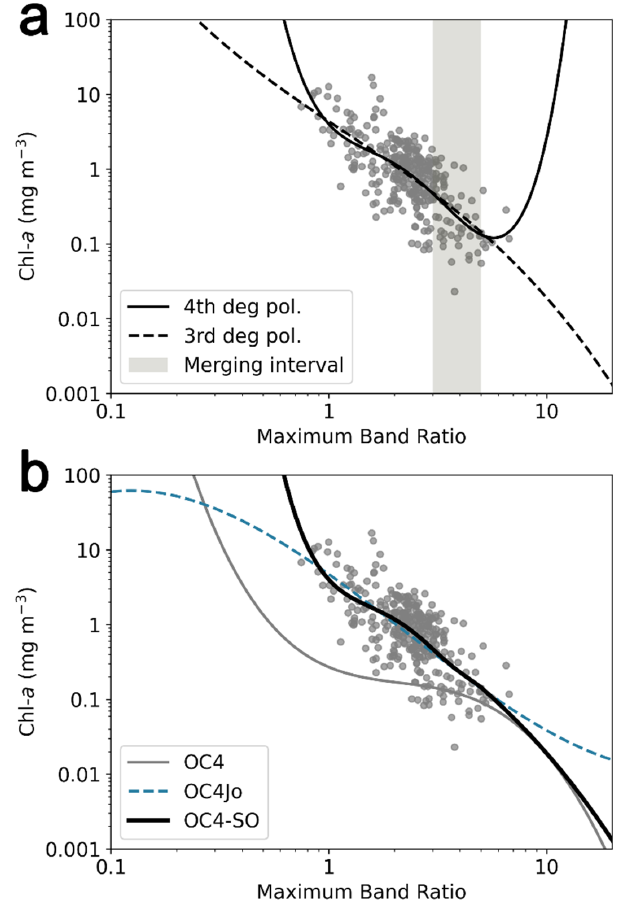
Figure 8. Relation between the in-situ Chl- a concentration and satellite maximum band ratio found for the match-ups in this study (N = 316). ( a ) Fitted 3rd- and 4th-degree polynomial functions that were used to derive the OC4-SO algorithm, along with the merging interval between MBR = 3 and MBR = 5, which was used to merge the two polynomial functions. ( b ) Comparison of the new algorithm (OC4-SO) and the regional OC4Jo. The global algorithm’s OC4 function [58] is also shown for comparison. Table 4. Coefficients for each function (the 3rd- and 4th-degree polynomial functions identified in this study; Figure 8) required for implementing the OC4-SO